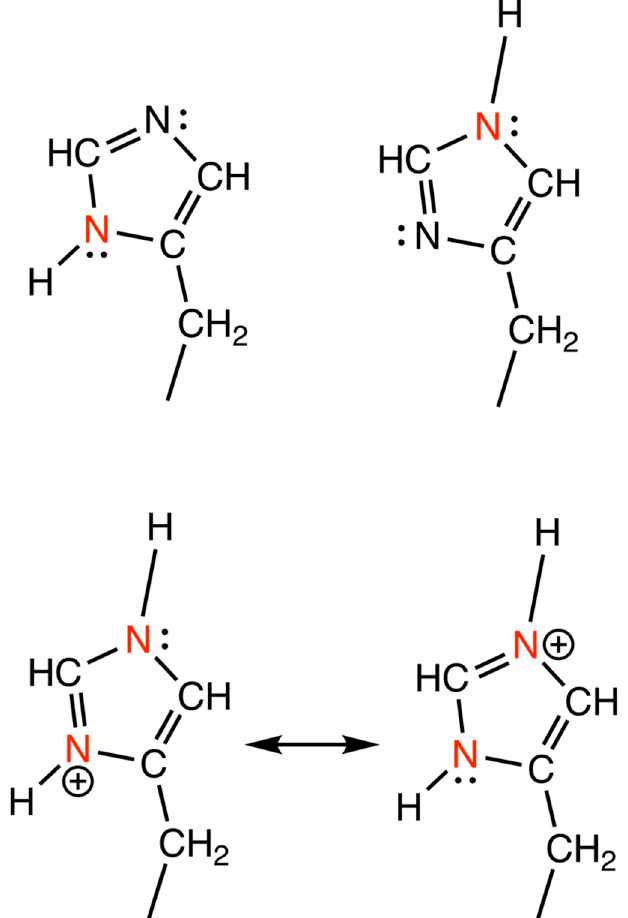
Figure 3. Protonated states of the imidazole ring of histidine side-chain. The top panel represents the singly protonated states with N δ 1 protonated in the left figure and N ε 2 protonated in the right. The bottom panel represents the resonance forms of the doubly protonated state. All the protonated nitrogen atoms are colored in red. The figure was prepared using ChemDraw. The doubly deprotonated state is not physiologically relevant due to a p K a of 14.5, hence not included in these structures. The functions derived from these parameters are: